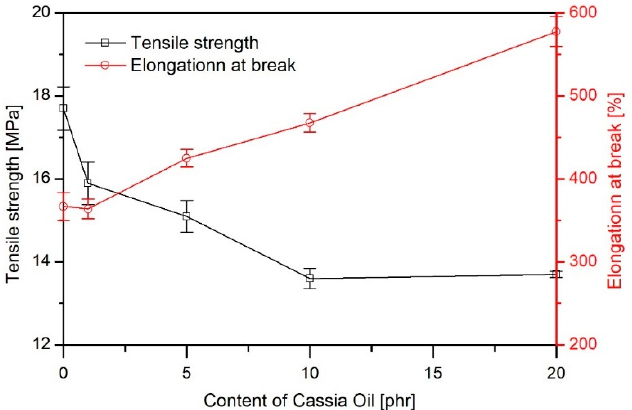
Figure 3. Tensile strength and elongation at break as a function of CO in the PVC matrix.